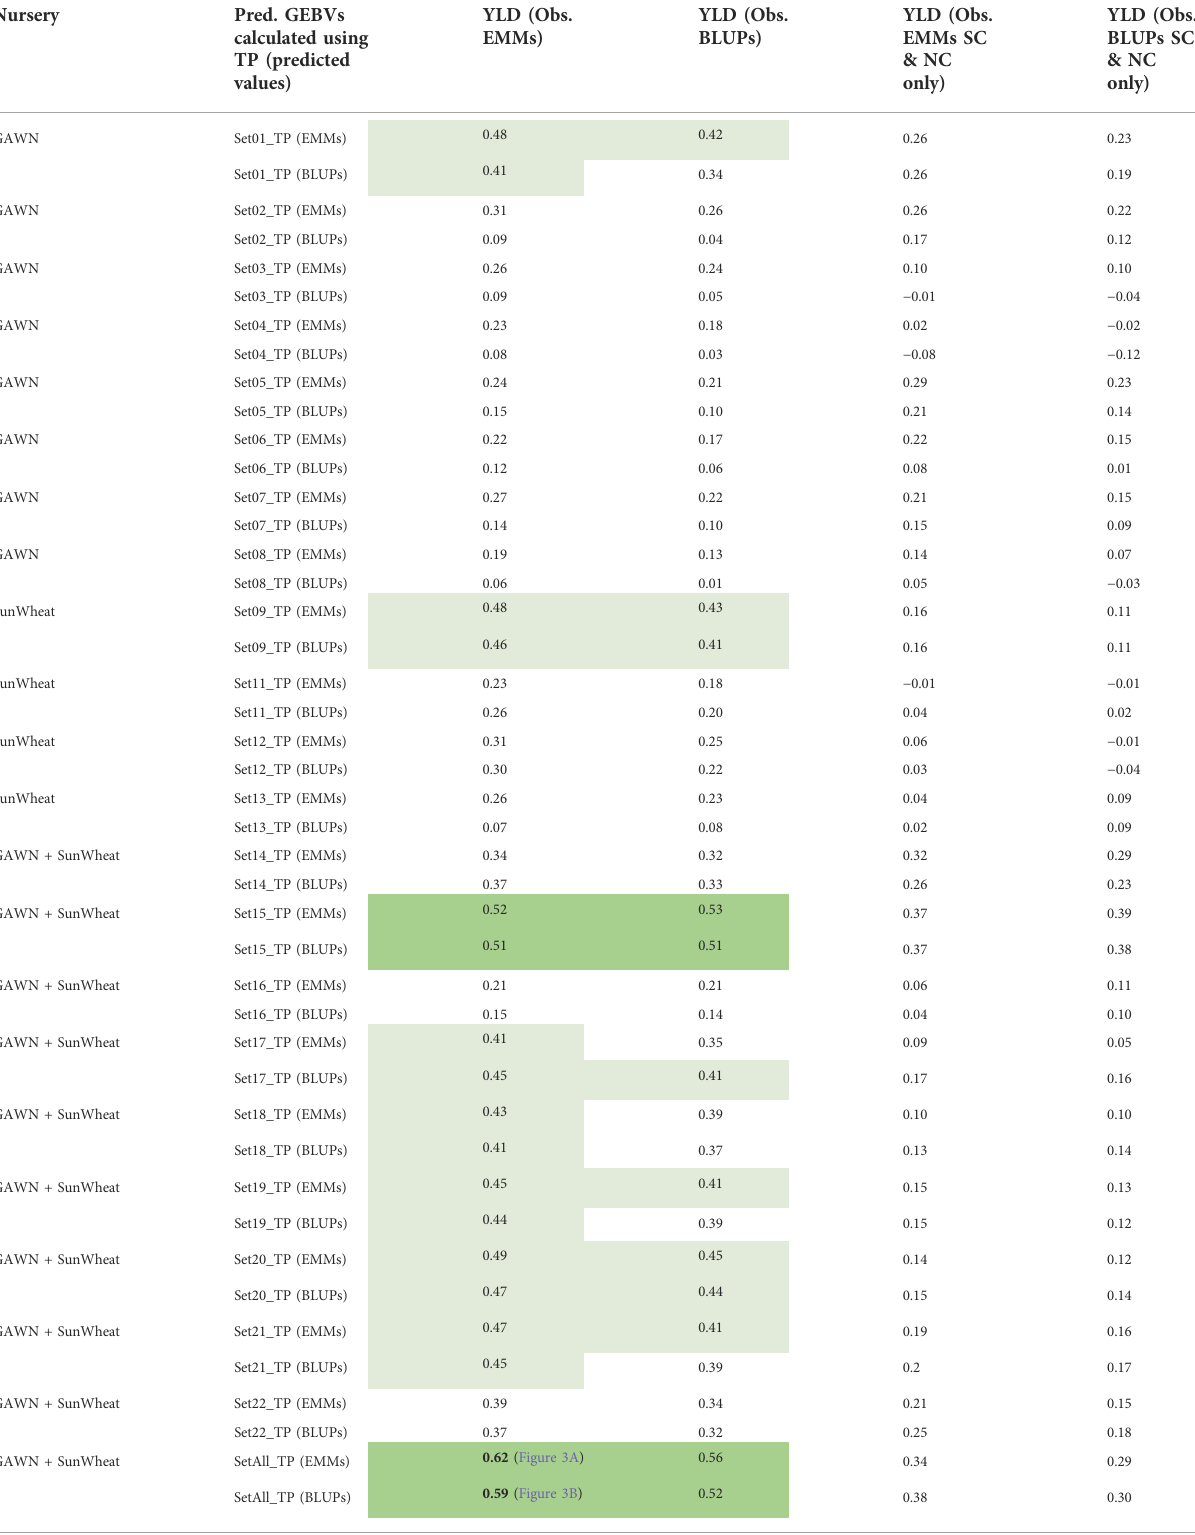
TABLE 2 Validation using estimated values (EMMs and BLUPs) of 22 TPs (Supplementary Table S2) and the prediction accuracy to predict GEBVs for YLD of 58 lines developed in Florence, SC. Nursery Pred. GEBVs calculated using TP (predicted values)